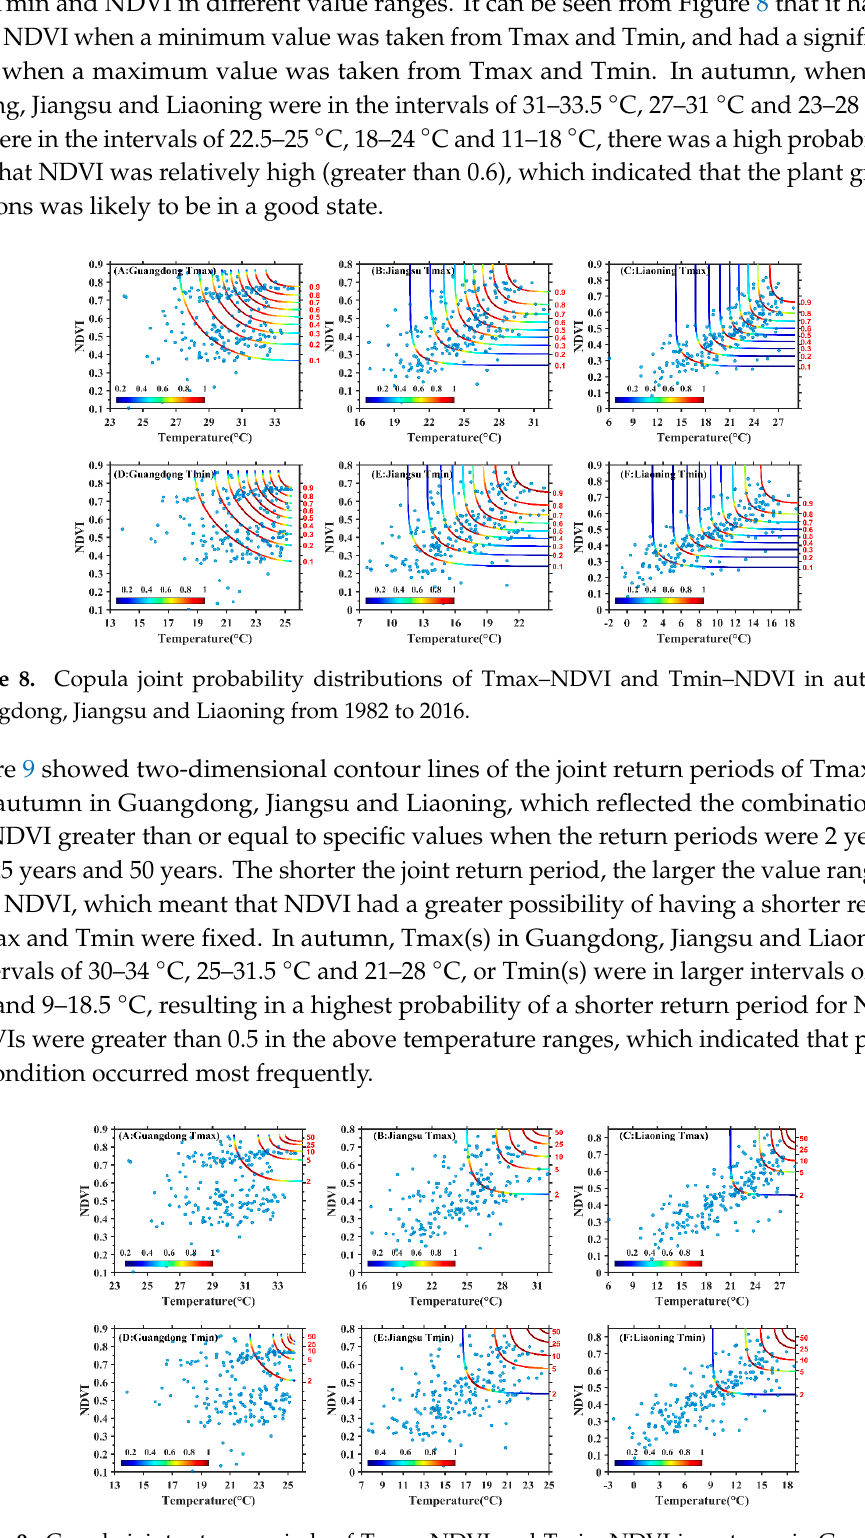
Figure 9. Copula joint return periods of Tmax–NDVI and Tmin–NDVI in autumn in Guangdong, Jiangsu and Liaoning from 1982 to 2016.